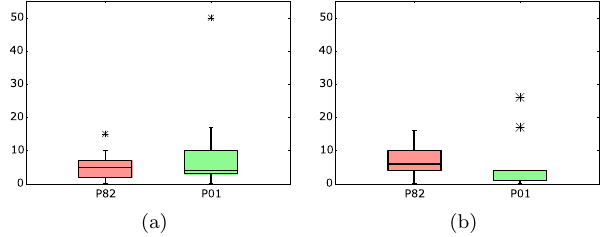
Figure 11: Distribution of results in the measurement of width (a) and height (b) - Car park entrance P01 and P82